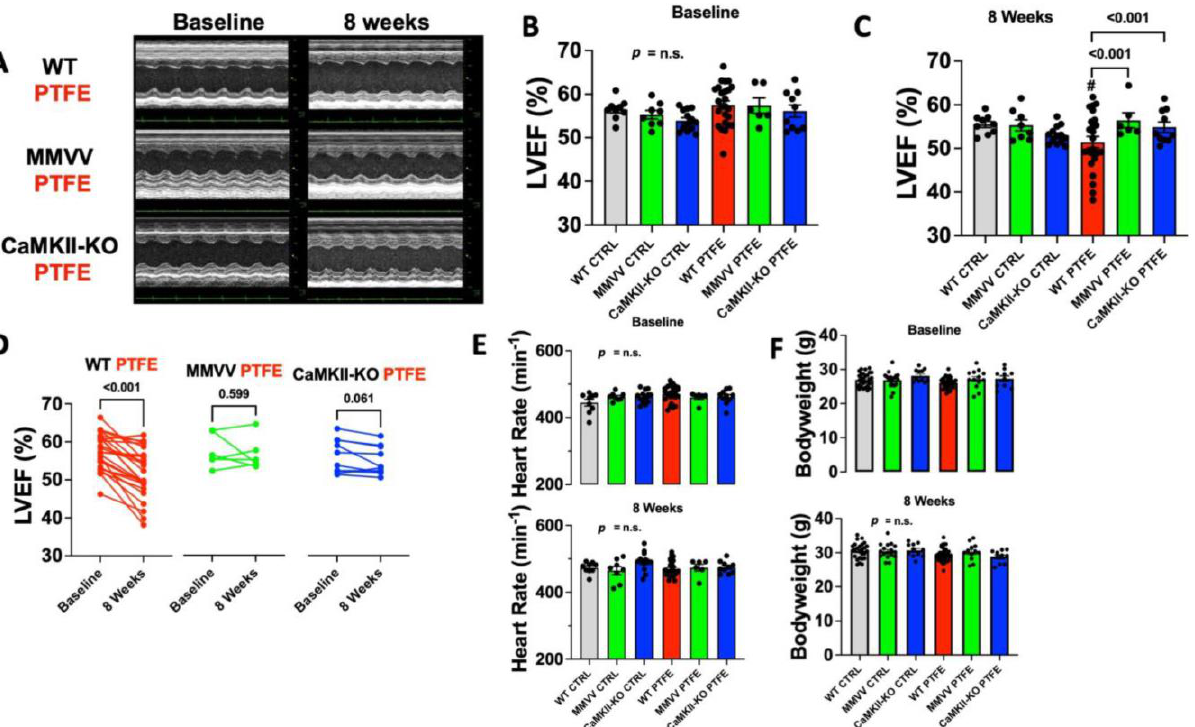
Figure 2. ( A ) Original M-mode echocardiographic traces of left ventricle. ( B ) Mean left ventricular ejection fraction per animal at baseline (CTRL groups: n = 9 WT, n = 8 MMVV, n = 13 CaMKII-KO; PTFE groups: n = 25 WT, n = 6 MMVV, n = 10 CaMKII-KO; ANOVA p = n.s.). ( C ) Mean left ventricular ejection fraction per animal after 8 weeks, # indicates p < 0.05 vs. WT PTFE at baseline. ( D ) Before–after presentation of PTFE group data from ( B , C ). ( E ) Heart rate during echocardiography from ( B , C ). ( F ) Animal body weight at baseline and after 8 weeks. Statistical comparisons are based on